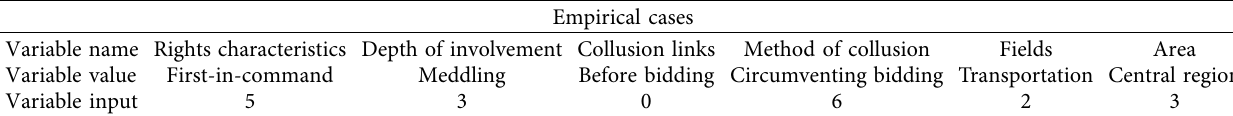
Table 7: efinition of case